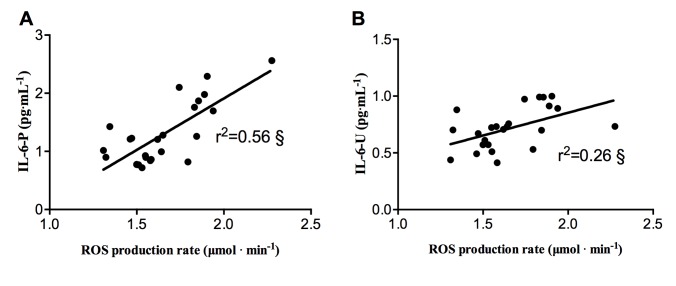
ROS-Interleukin correlation at Pre-Race in FR.Plots of ROS production rate levels (μmol. min-1) versus: A) IL-6 in plasma (IL-6-P) and B) IL-6 in Urine (IL-6-U). The significant (§ P<0.001) linear relationship (solid line) is also shown and the correlation coefficient (r2) reported in each panel.